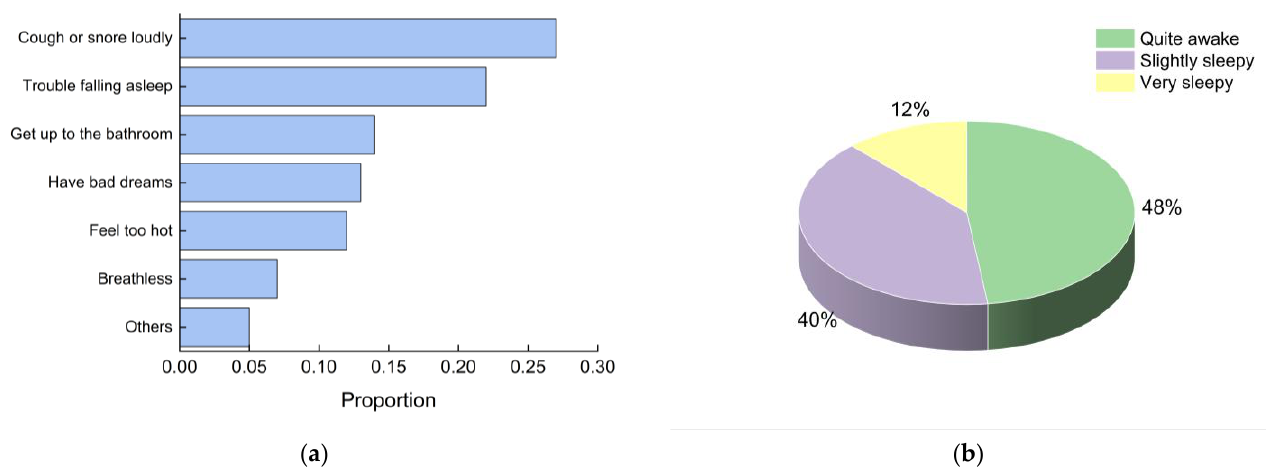
Figure 12. Subjective evaluation of sleep quality: ( a ) factors affecting sleep quality; ( b ) state upon waking up.